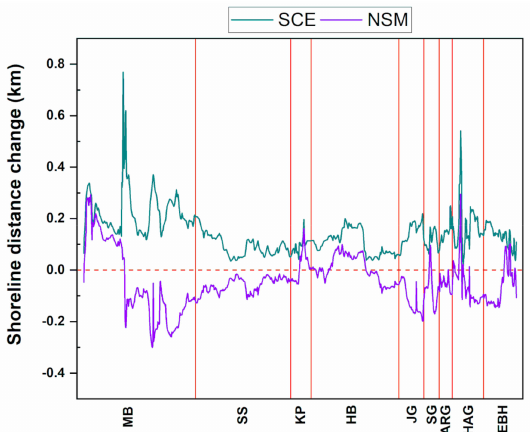
Figure 8. Shoreline change (NSM, SCE) of the western zone (MB = Manora Beach, SS = Sandspit, KK = Kaka Pir, HB = Hawks Bay, JG = Jamali Goath, SG = Somar Goath, ARG = Abdul Rehman Goath, HAJ = Haji Ali Goath, EBH = Engro Beach